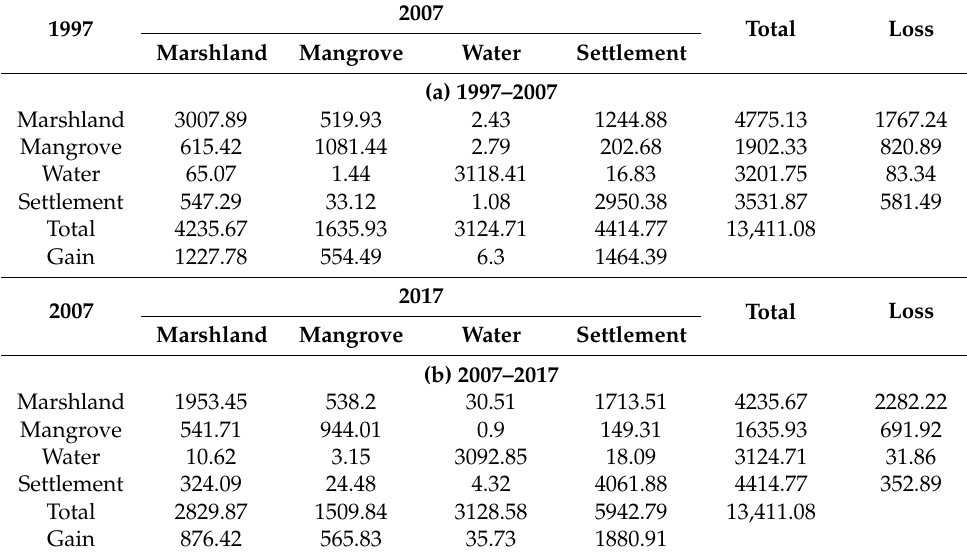
Table 3. LUC transitions in the MMNL (ha).